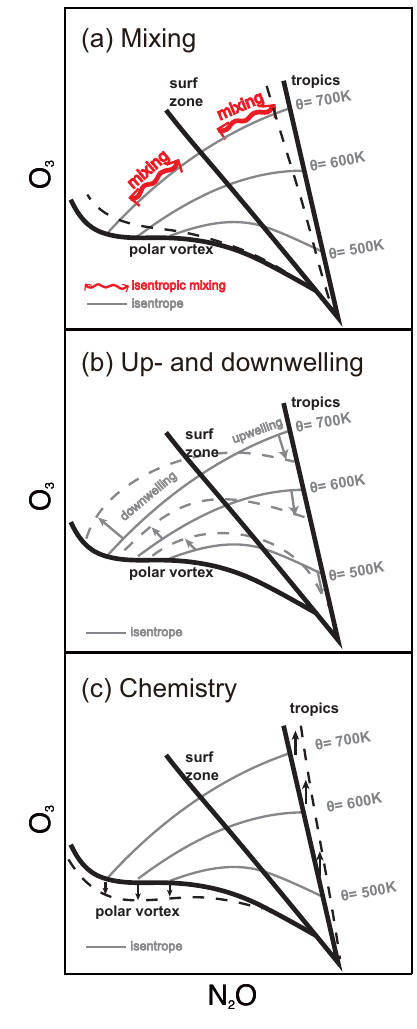
Figure 1. Schematic diagram showing the influences of (a) mixing, (b) up- and downwelling and (c) chemistry on N 2 O–O 3 correla-